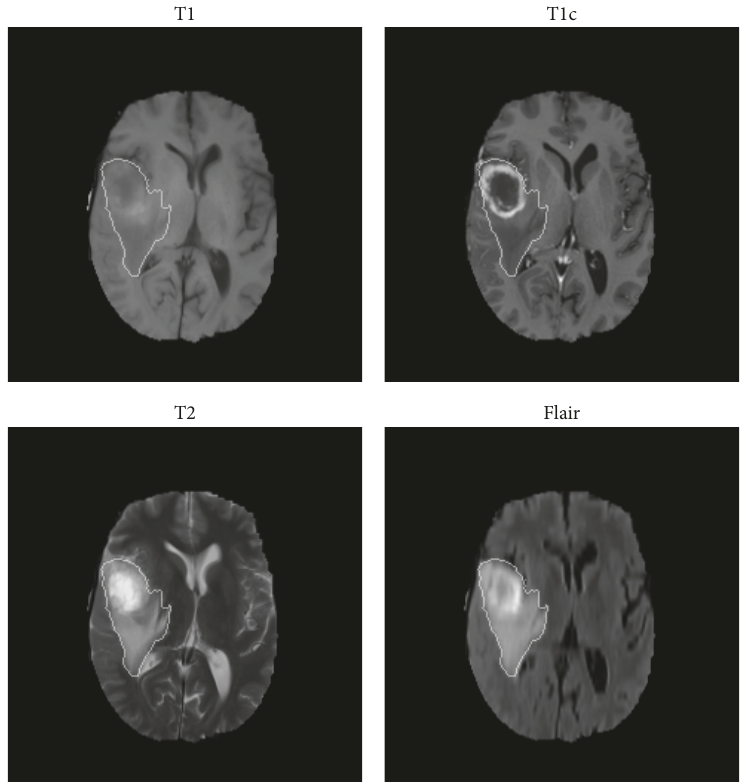
Figure 2: The whole tumor region with ground truth segmentation.